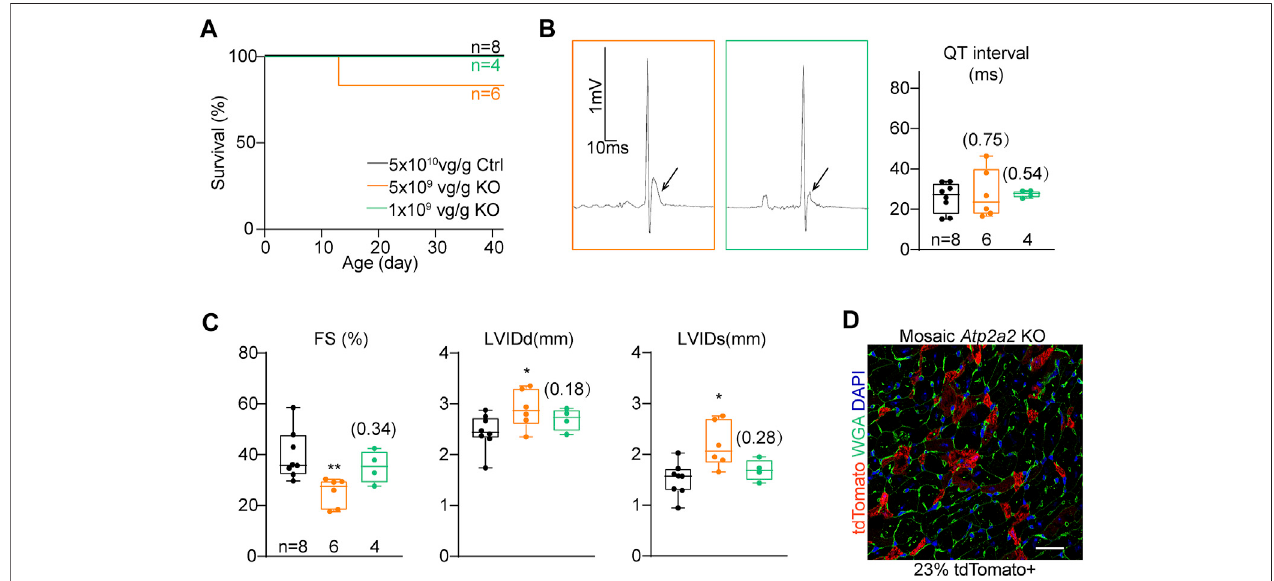
FIGURE 4 | The titration of AAV dosages for genetic mosaic analysis. (A) , Survival analysis of animals treated with high-dose control (Ctrl) and titrated Atp2a2 knockout (KO) AAVs. B , Representative electrocardiogram traces of animals with titrated AAV doses and the relevant QT interval quanti fi cation. Arrows point to ST segments. (C) , Echocardiogram analysis of animals with titrated AAV doses. In (B) and C , box and whisker plots were presented to show individual data points (dots), 25%-50% – 75% percentiles (horizontal lines in the boxes) and maximal/minimal values (whiskers). Unpaired two-tailed student ’ s t-test: * p < 0.05, ** p < 0.01, non- signi fi cant p values in parenthesis. ( D) , A representative image of ventricle sections from hearts treated with the low-dose AAV. Scale bar, 20 μ m.